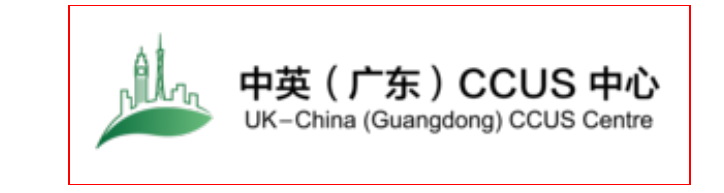
Figure 29. The Canton CCUS center ’ s logo.